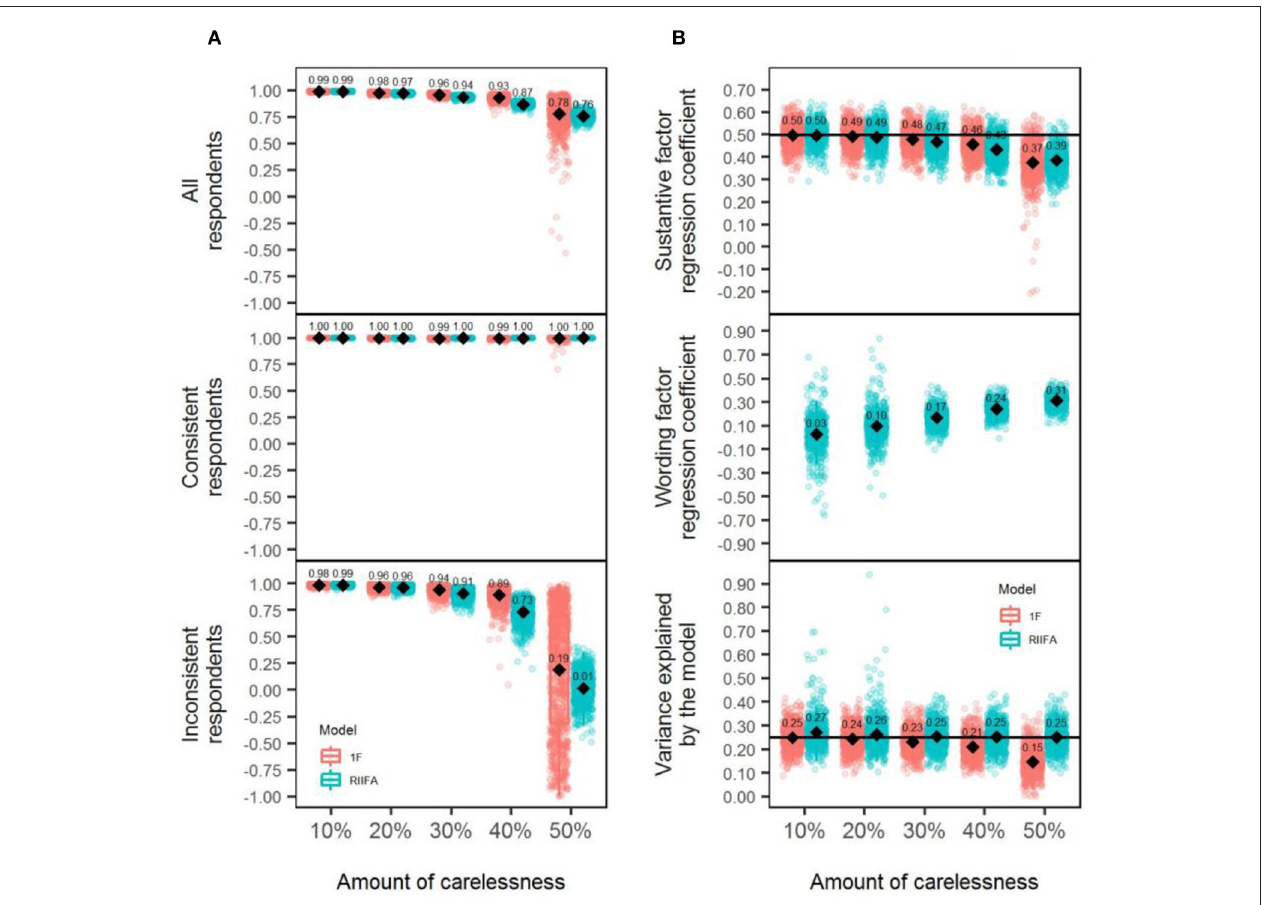
FIGURE 3 | Recovery of substantive factor scores and estimation of structural validity with the 1F model and the RIIFA model in the presence of carelessness. In (A) , represented values are Pearson correlations, and results of the recovery of uncontaminated scores are presented for all the respondents, separately for consistent respondents, and separately for inconsistent respondents. 1F, unidimensional model with one substantive factor; RIIFA, random intercept item factor analysis model with one substantive factor and one wording method factor. In (B) , the horizontal black lines represent the substantive factor regression coefficient and the variance explained by the model with 0% of wording